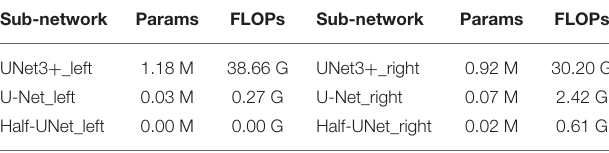
TABLE 4 | In the analysis table of the three sub-networks in Figure 6 .